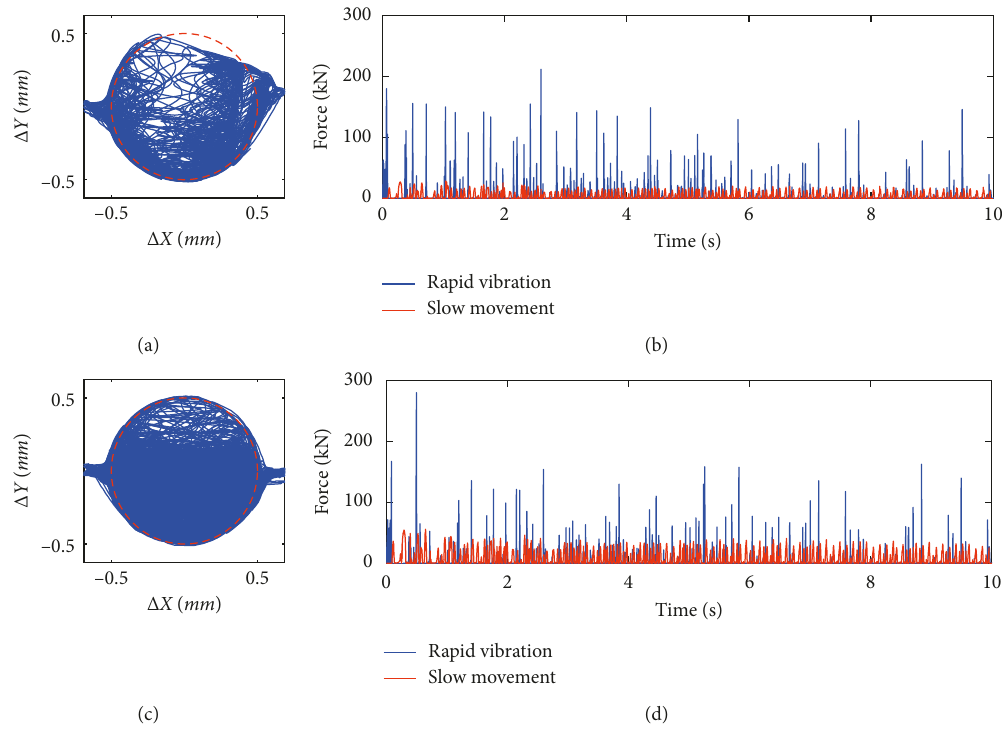
Figure 10: Trajectories and impact forces in clearance joints P